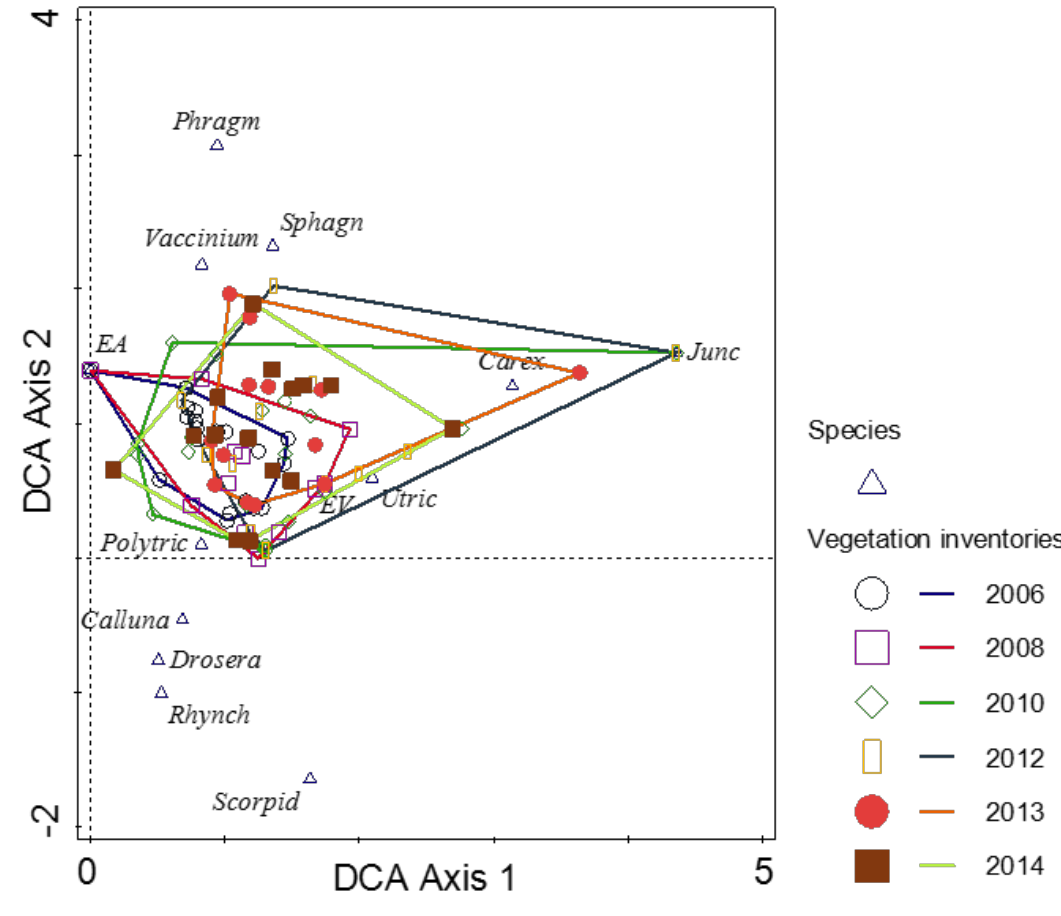
Figure 5. Detrended Correspondence Analysis (DCA) of 95 vegetation relevés in the Porla wetland. Empty triangles show relative species positions. Envelopes are plotted for symbols showing relative positions of vegetation relevés according to the year of observation. Scaling of axes is in SD units. Total inertia (variance) is 2.188. Eigenvalues of Axis 1 and Axis 2 are 0.516 and 0.277, respectively. Abbreviations of plant species names are given in Table